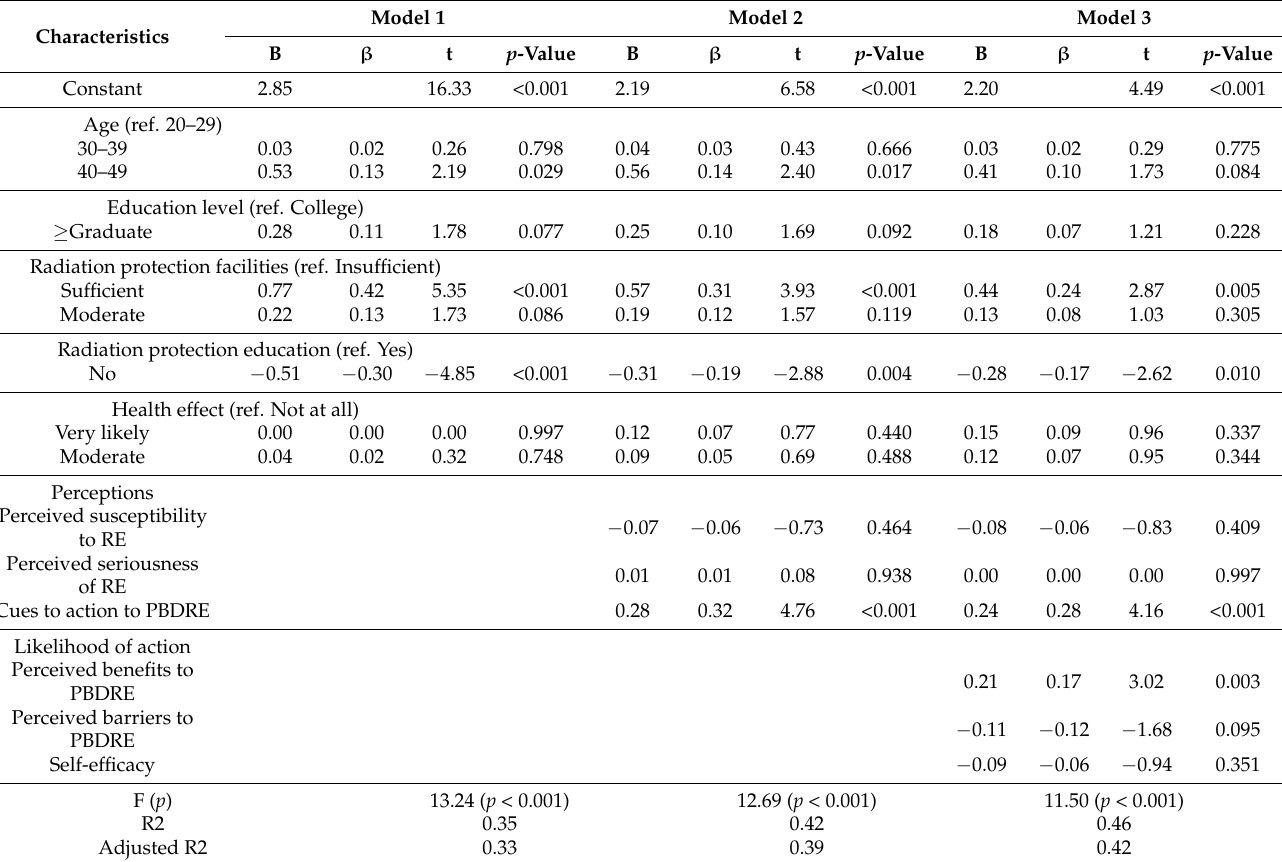
Table 4. Hierarchical multiple regression analysis of